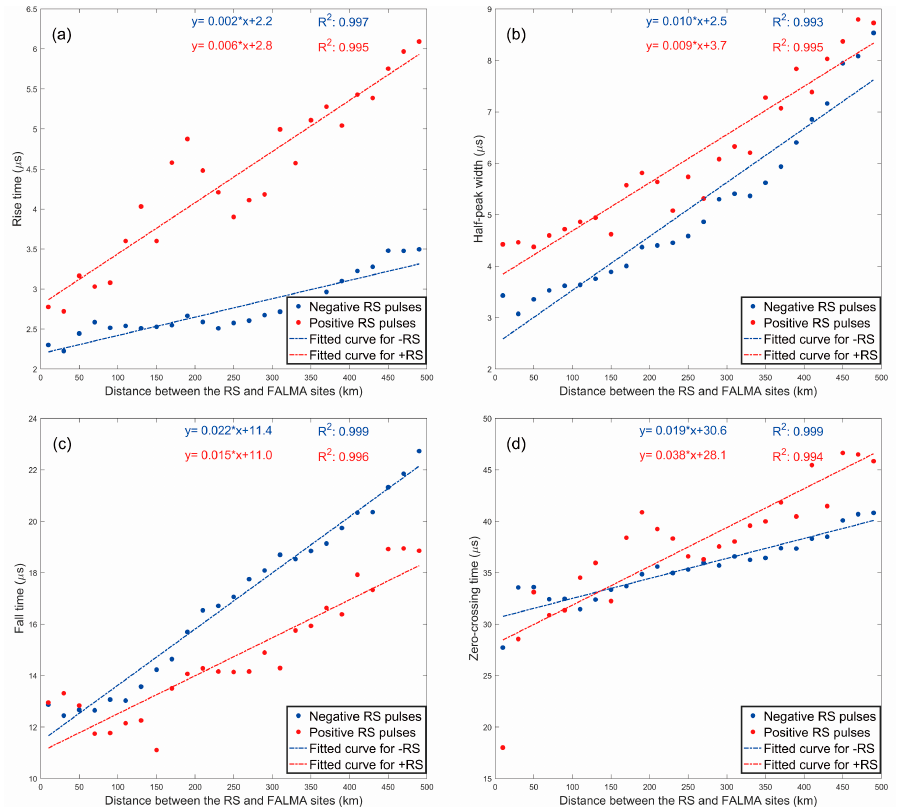
Figure 10. Scatterplots of the mean values for positive (red dots) and negative (blue dots) RS pulse parameters in different distance ranges. The fitted curves of pulse parameters by distance are represented by dashed lines with the equation and fitting goodness marked on the upper of subplots.